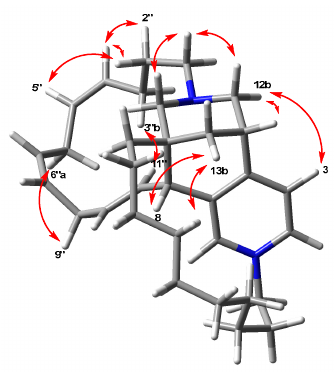
Figure 2. Selected NOE correlations.